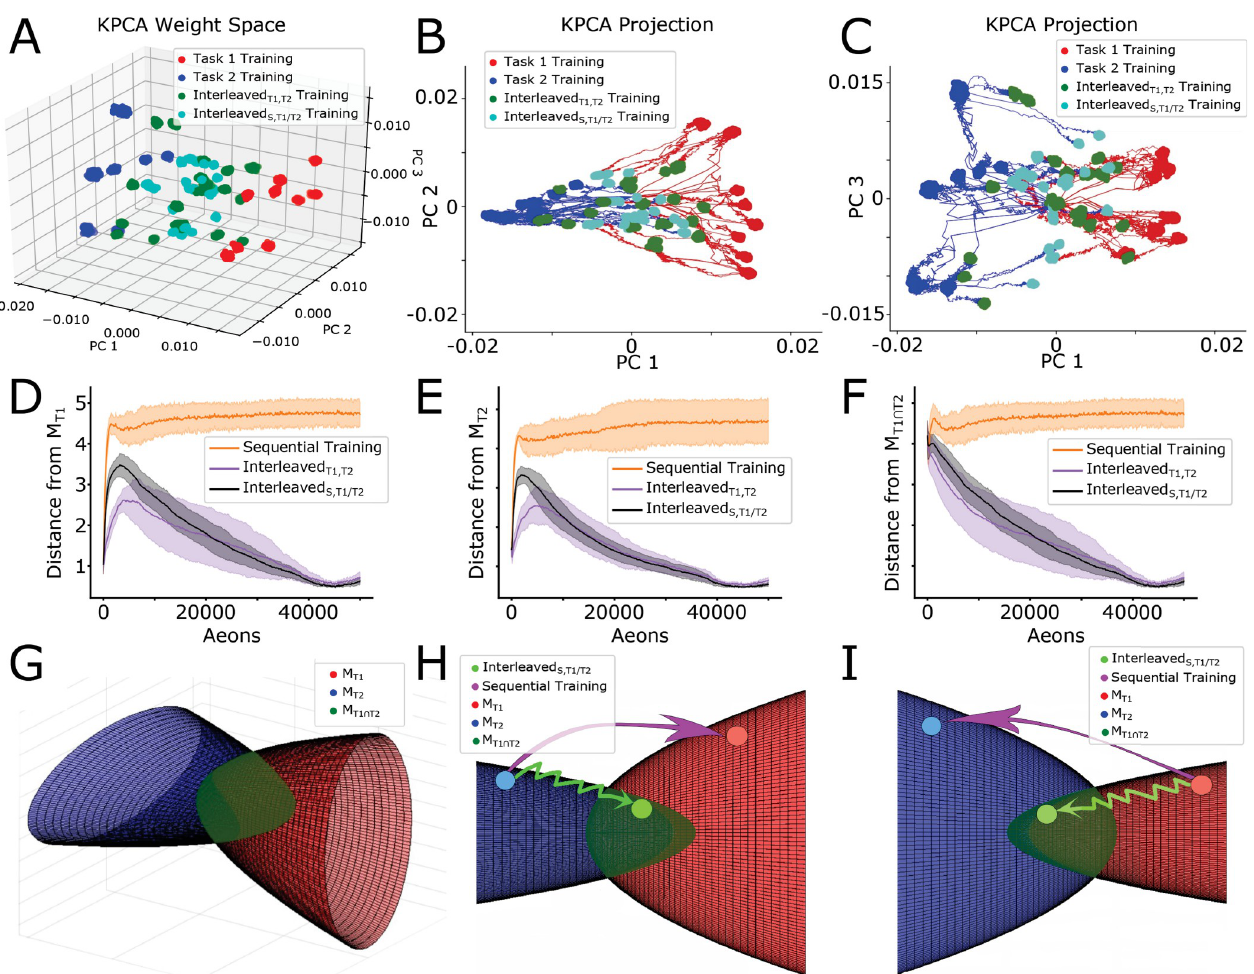
Fig 7. Periods of sleep push the network towards the intersection of Task 1 and Task 2 synaptic weight manifolds. (A-C) Low-dimensional visualizations of the synaptic weight configurations of 10 networks obtained through kPCA for 3-dimensions (A) and 2-dimensions (B-C). Synaptic weight configurations taken from the last fifth of Task 1 (red dots), Task 2 (blue dots), Interleaved T1,T2 (green dots), and Interleaved S,T1/T2 (cyan dots) training are shown. Trajectories resulting from Interleaved T1,T2 and Interleaved S,T1/T2 training following Task 1 (Task 2) training are shown in red (blue). (D-F) Average (solid lines) and standard deviation (shaded regions) of the Euclidean distances between the current synaptic weight configuration and M during Sequential (orange), Interleaved T1,T2 (purple), and Interleaved S,T1/T2 (black) training. (G) Cartoon illustration of the task-specific point-sets shown in (A-C) as solution manifolds M T1 (red) and M T2 (blue). M T1 and M T2 can be thought of as two volumes with boundaries defined by the interiors of oppositely oriented elliptic paraboloids which intersect orthogonally defining an approximately ellipsoidal volume near the origin (M T1 \ T2 ; dark green). (H, I) Sequential training (pink arrow) causes the network to jump from one solution manifold to the other while avoiding M arrow) keep the network close to the initial solution manifold as it converges towards M T1 \ T2